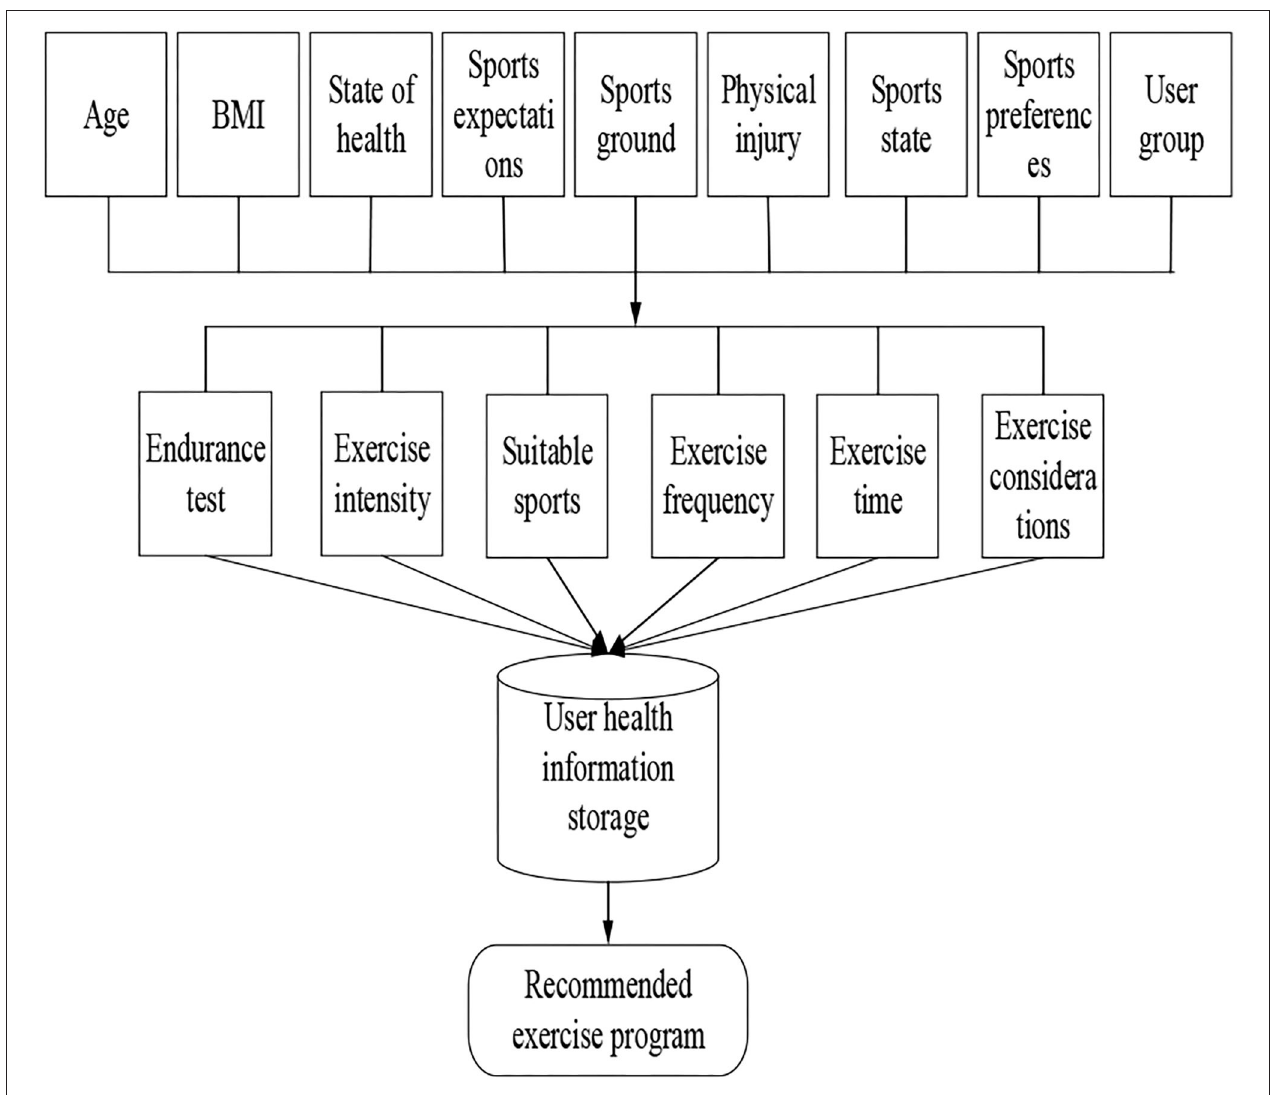
FIGURE 3 | Sports scheme recommendation